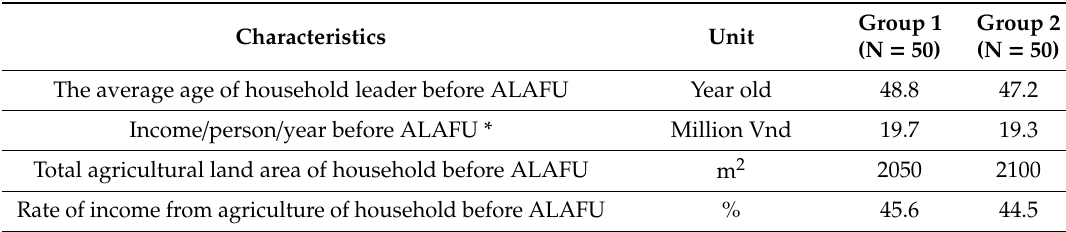
Table 1. Characteristics of the surveyed